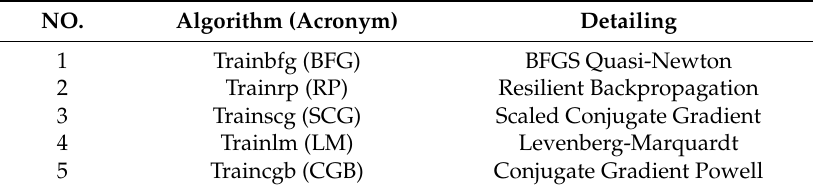
Table 2. Various algorithms for NN model.